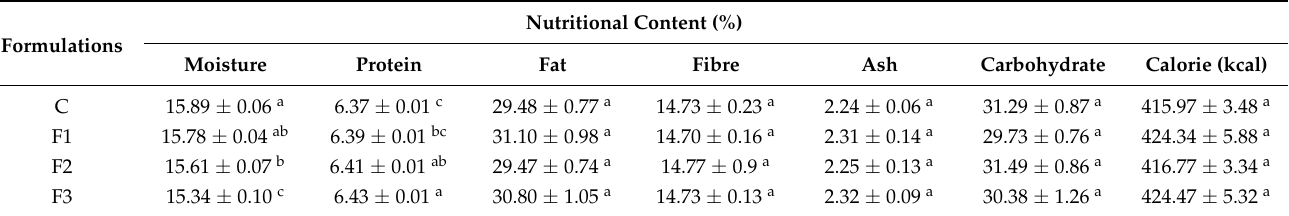
Table 2. Nutritional content of control and GABA-enriched dark